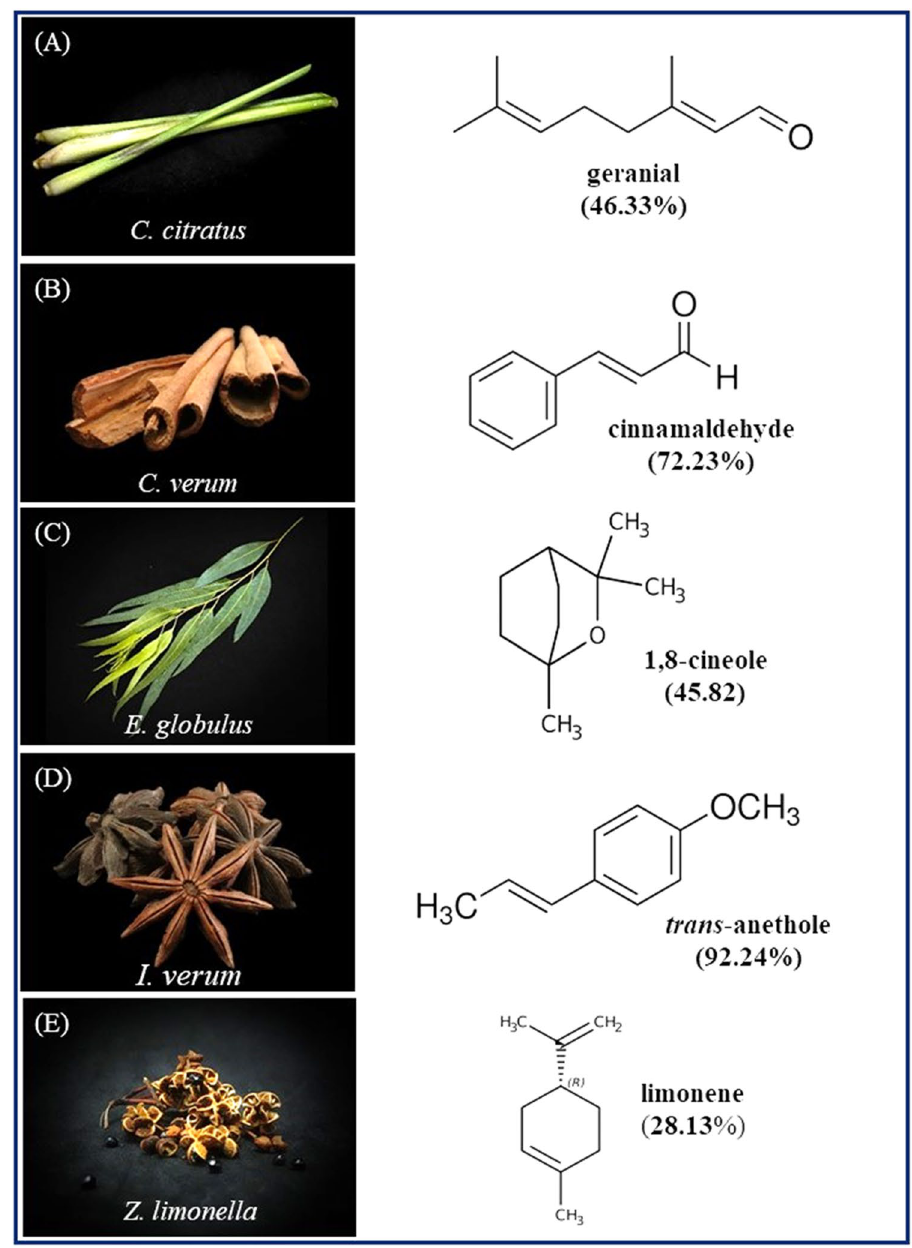
Figure 2. Cymbopogon citratus stems ( A ), Cinnamomum verum bark ( B ), Eucalyptus globulus leaves ( C ), Illicium verum fruits ( D ), and Zanthoxylum limonella fruits ( E ) as well as the chemical structures of their major essential oil (EO)